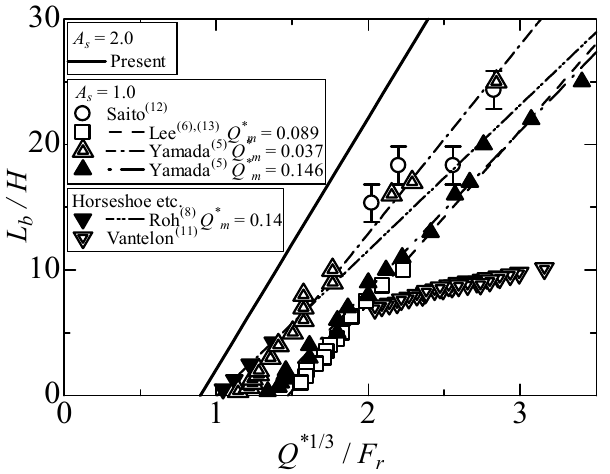
Fig. 9 Relationship between L b / H and Q *1/3 / Fr . The comparison between the present study and previous work by Saito et al., Lee et al., and Yamada et al. using a model tunnel with a rectangular cross section of aspect ratio unity, by Roh et al. using a model tunnel with a horseshoe-shape cross section, and by Vantelon et al. using a model tunnel with a semicircular cross